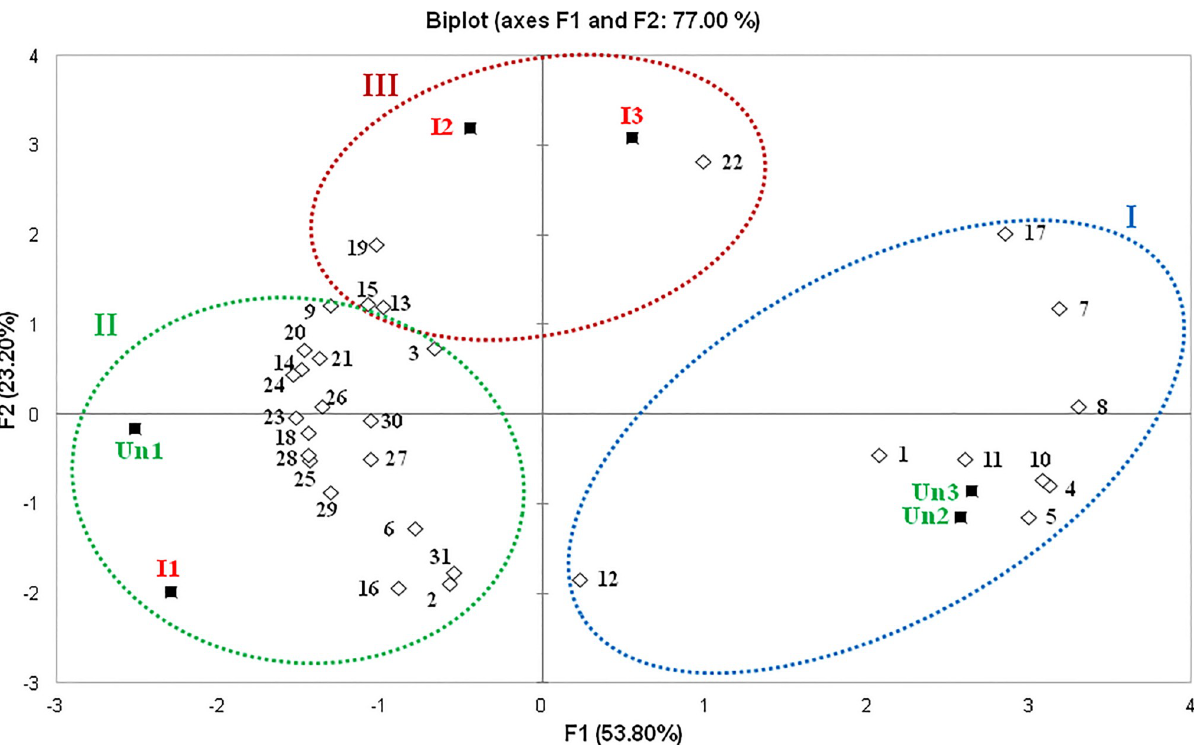
Fig 6. Principal component analysis and classification of clusters (I, II and III) of identified volatile compounds extracted from the different uninfected (Un1, Un2 and Un3) and infected (I1, I2 and I3) mice.